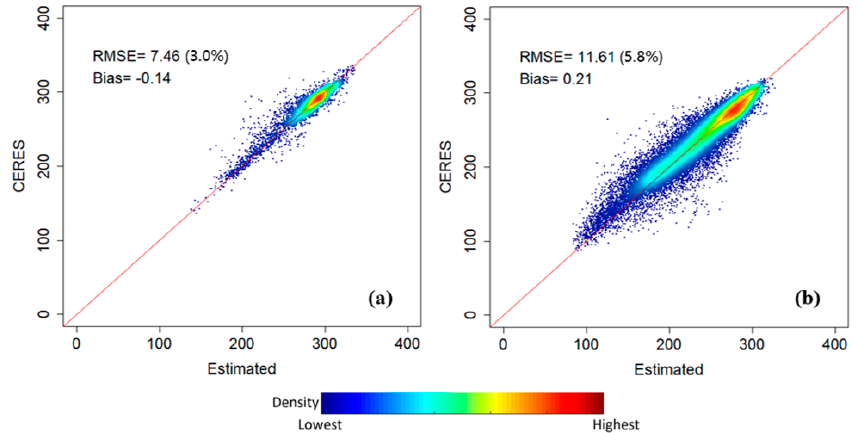
Figure 2. Test results of the TOA OLR using GBRT under ( a ) clear − sky, ( b ) cloudy − sky conditions.